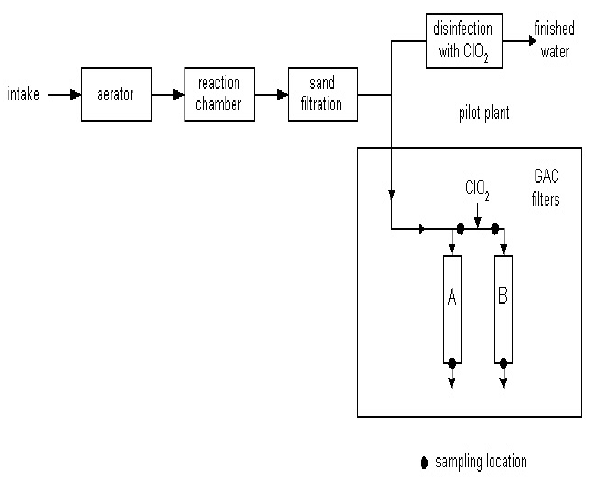
Fig. 2. Scheme of Mosina Water Treatments Plant and Mosina pilot plant